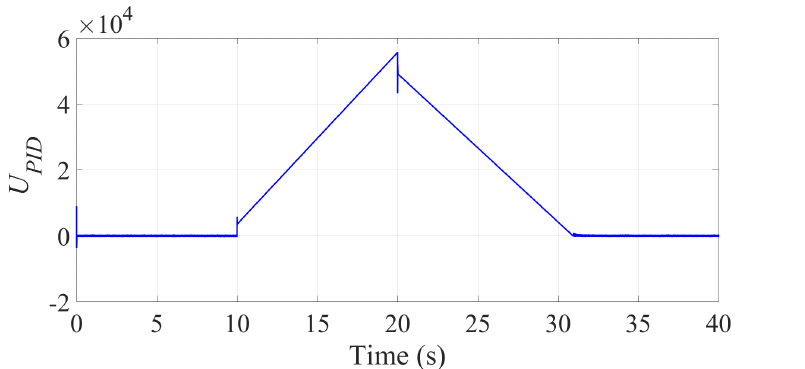
Figure 15. Scenario 2: Control input to generate the duty cycle of a PWM signal using a classical PID controller (simulation 2).